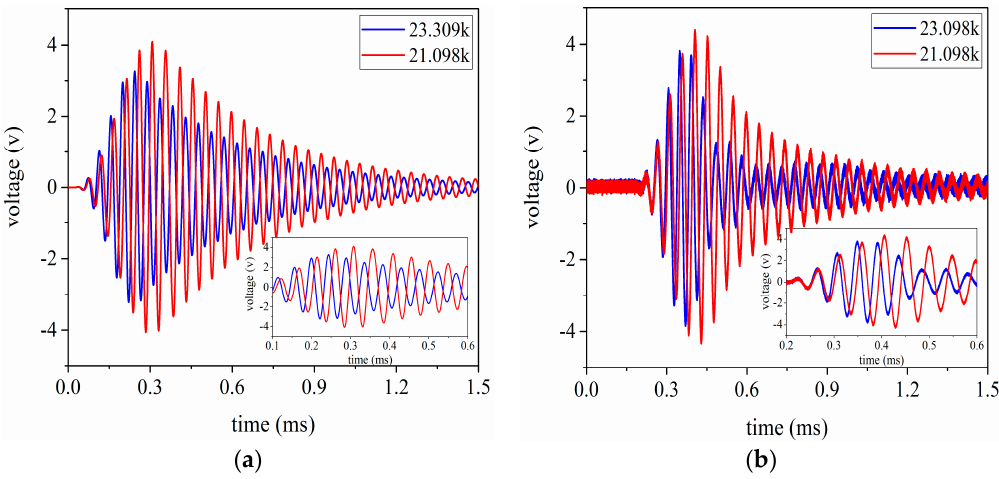
Figure 17. The signal waveform received by the ultrasonic transducer under the condition that the aluminum cylinder is 20 mm in length, ( a ) the simulated results; ( b ) experimental results.